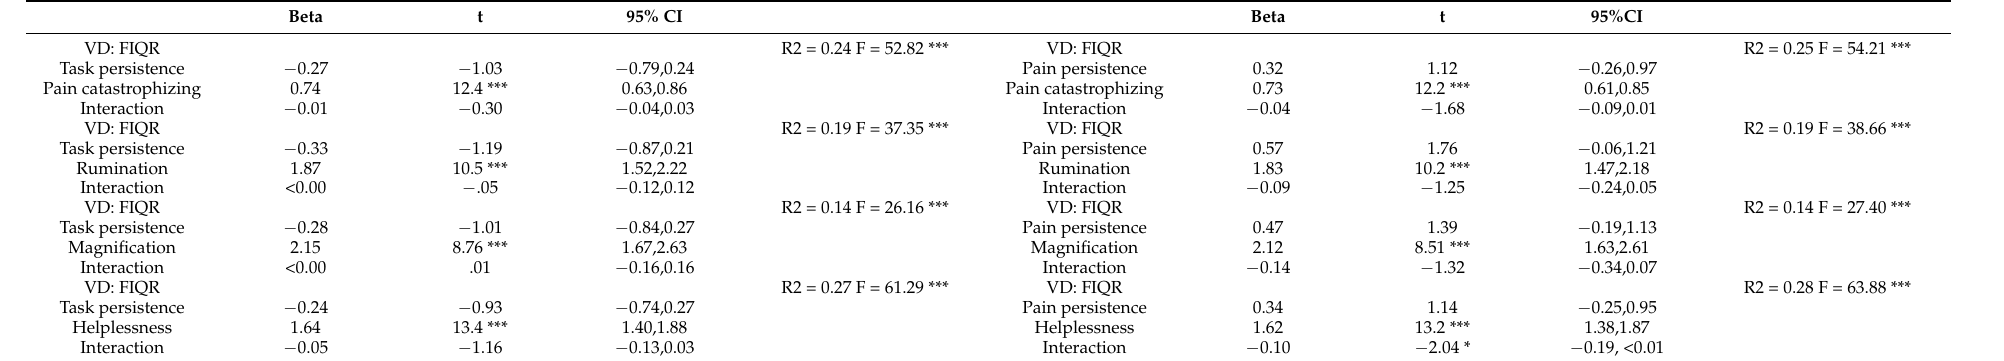
Table 4. Prediction of fibromyalgia impact from task-contingent persistence and pain-contingent persistence, pain catastrophizing (total score and dimensions), and their interaction.